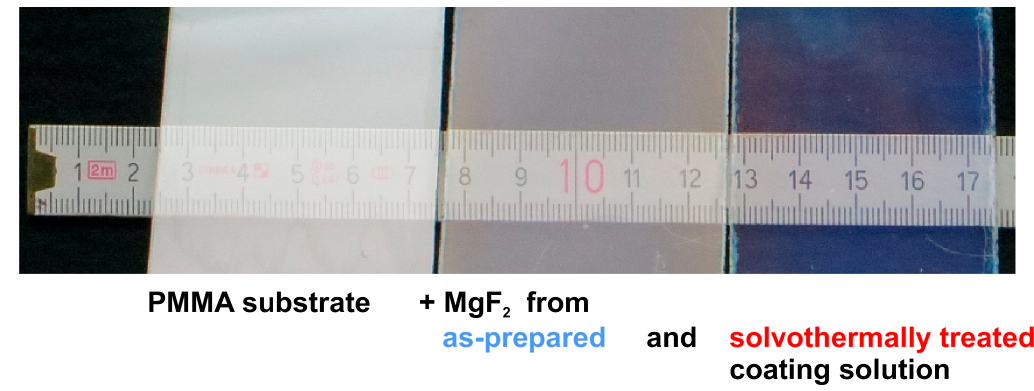
Figure 18. Photographs of bare PMMA substrate ( left ), PMMA coated with as-prepared MgF 2 coating solution ( middle ), and coating solution that had undergone solvothermal treatment ( right ). Based on [53].